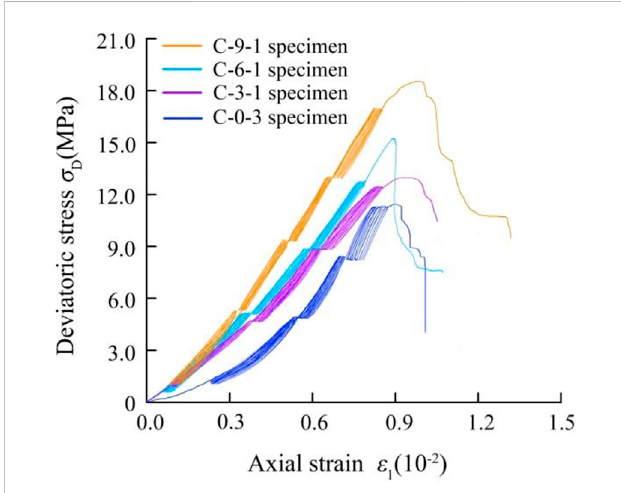
FIGURE 4 The σ D - ε 1 curves of coal specimens with cyclic loading and unloading at different stress lower limits under the different con fi ning